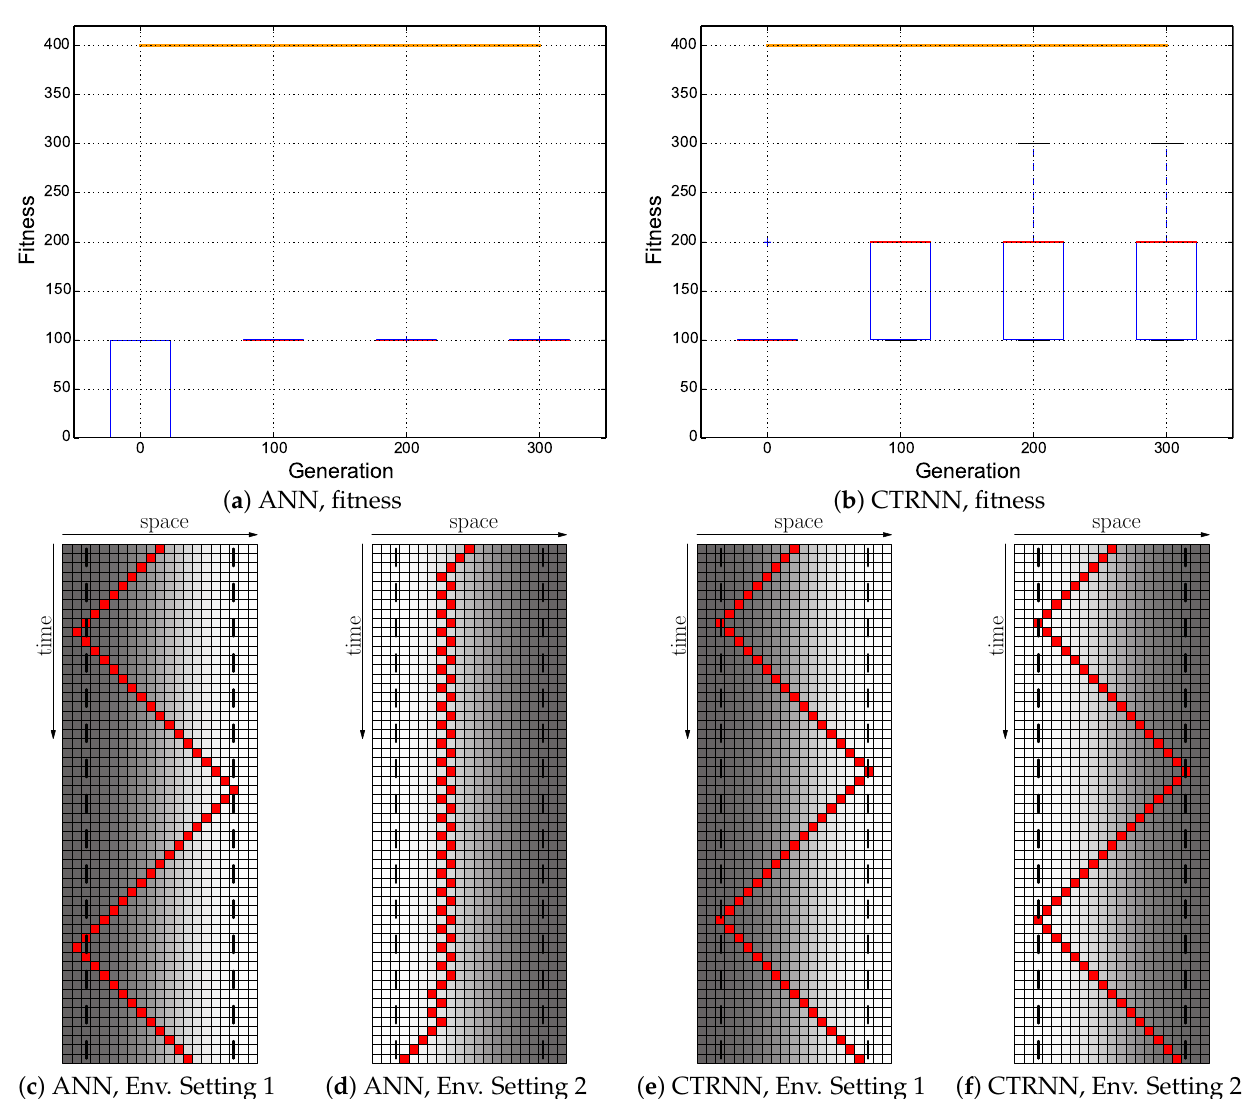
Figure 12. Evolutionary results of short evaluations with only 56 time steps, the Cumulative + Switch fitness regime: fitness = F ( 100,0.01,0 ) ; the minimum of both evaluations was used as the fitness value for each genome. Top row: fitness dynamics of the ANNs (left) and CTRNNs (right). The horizontal orange line indicates the maximum fitness achievable by a reactive Wankelmut controller, as it was achieved by the simple hand-coded controller. Bottom row: trajectory of the best performing genome of both controller types in both environments used in evolution (all 56 time steps are